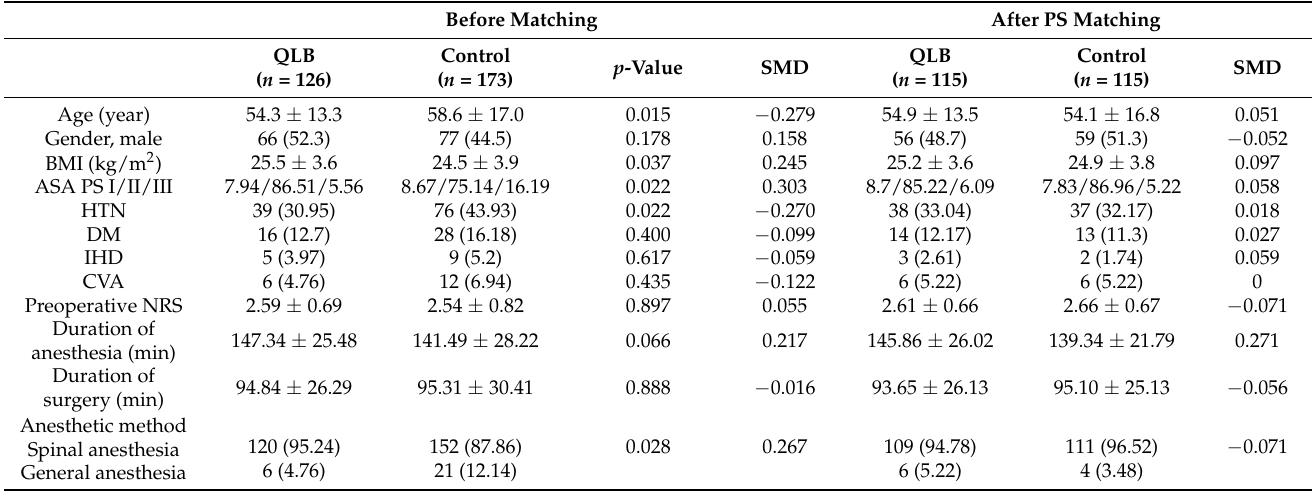
Table 1. Patient characteristics and perioperative variables.